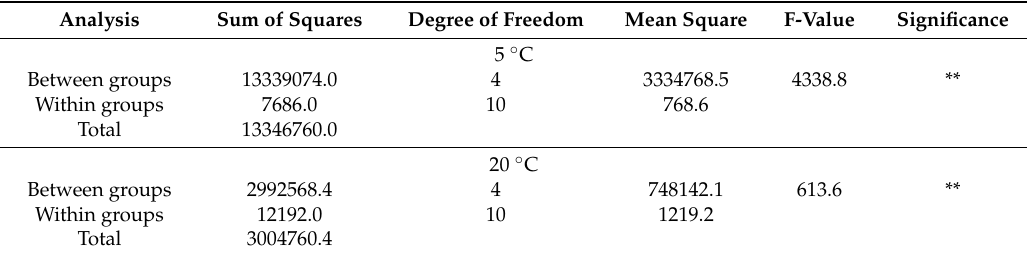
Table 8. One-way analysis of variance (ANOVA) for low-temperature ITSM.